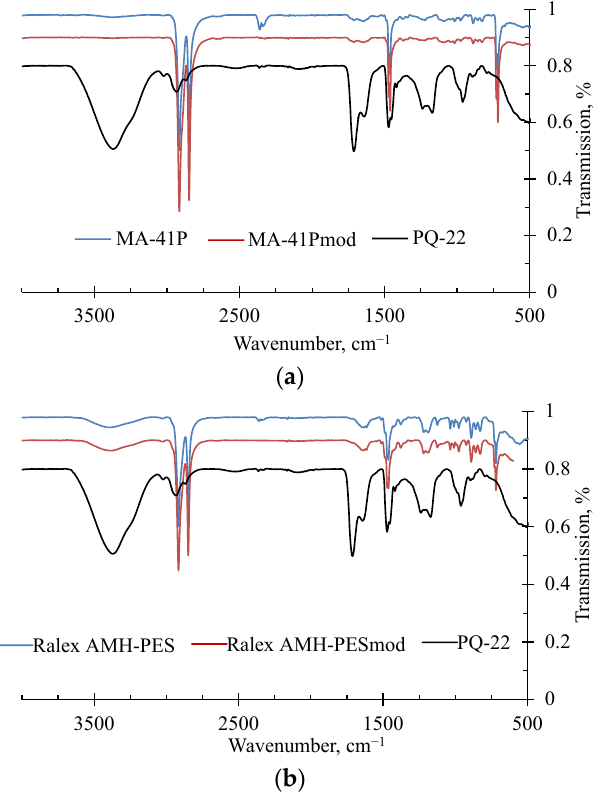
Figure 5. The FT-IR spectra of MA-41P and MA-41Pmod ( a ), Ralex AHM-PES and Ralex AHM- PESmod samples ( b ), and dry PQ-22 polymer film.